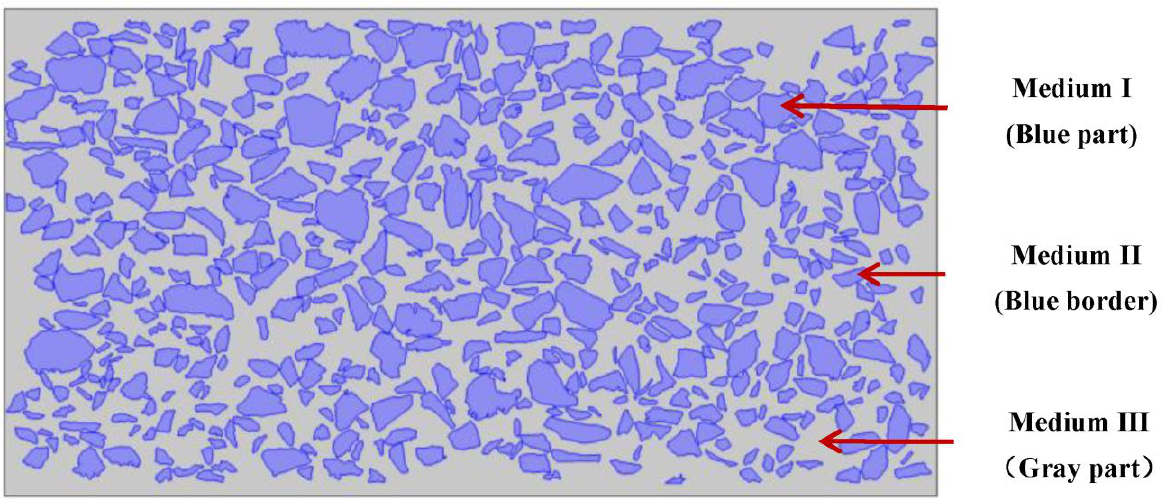
Figure 5. Numerical image of the asphalt mixture.